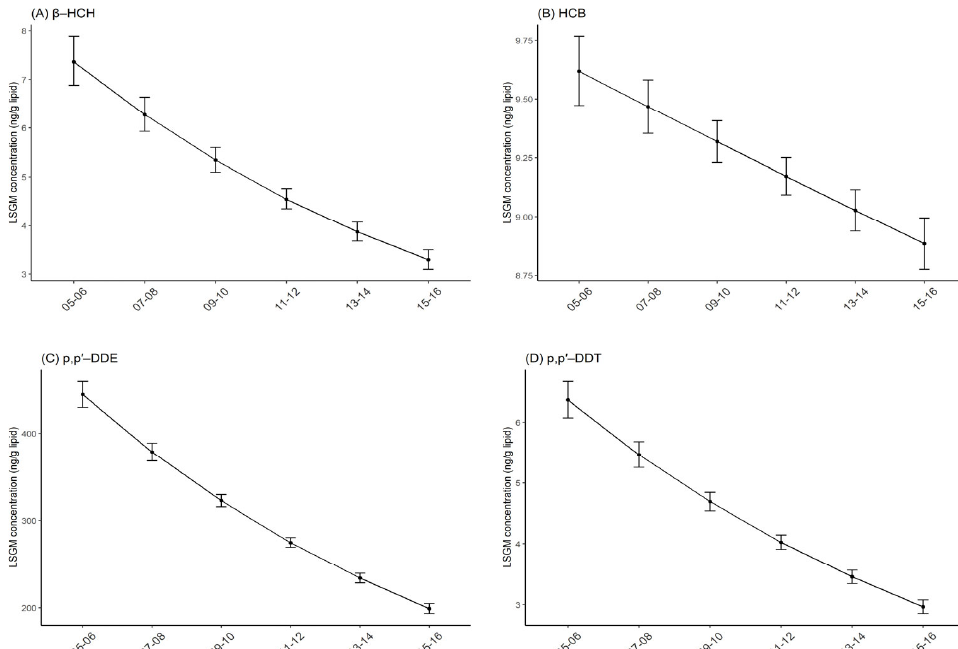
Figure 1. Temporal trends in serum OCP concentrations by survey cycles. Least square geometric mean (LSGM) and 95% confidence interval (95% CI) for each survey cycle estimated from linear regression models adjusted for survey cycles, sex, age and race/ethnicity. Data points represent LSGM, and error bars represent 95% CI. ( A ): β‐ HCH. ( B ): HCB. ( C ): p,p ′‐ DDE. ( D ): p,p ′‐ DDT.